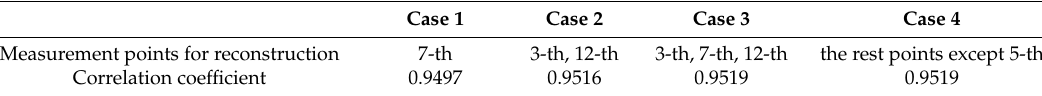
Table 5. Experimental results for 4 cases of the sensor number example.